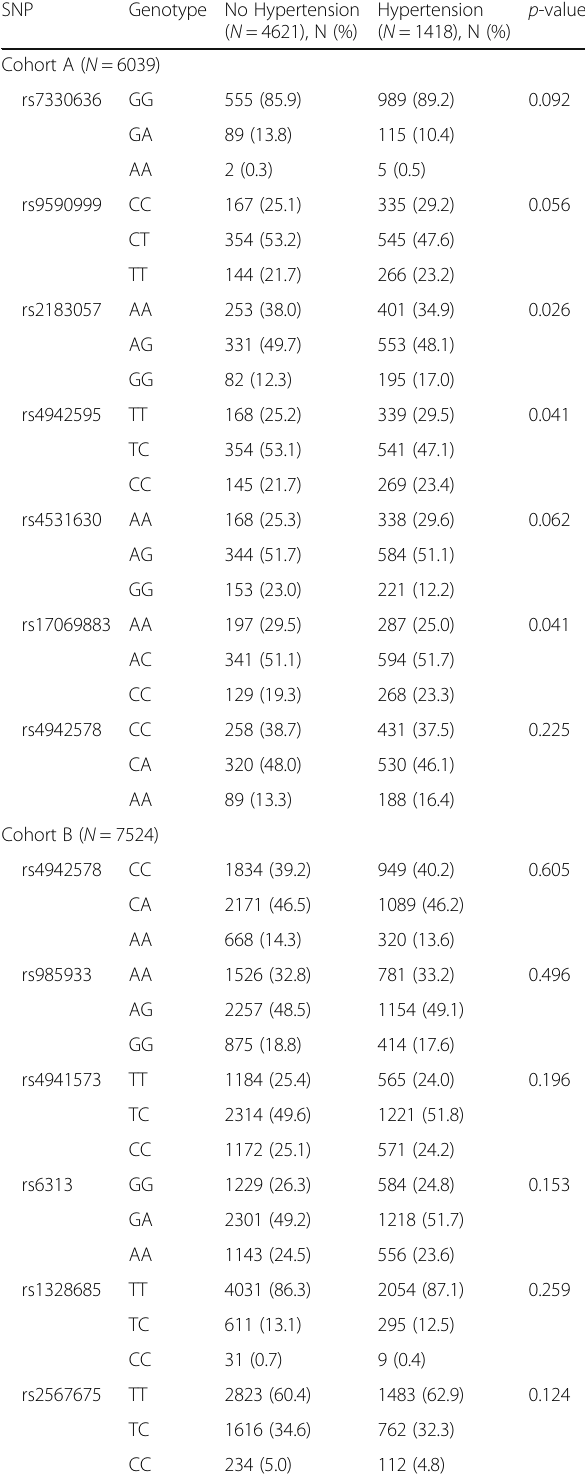
Table 2 Distribution of HTR2A genetic variations according to development of